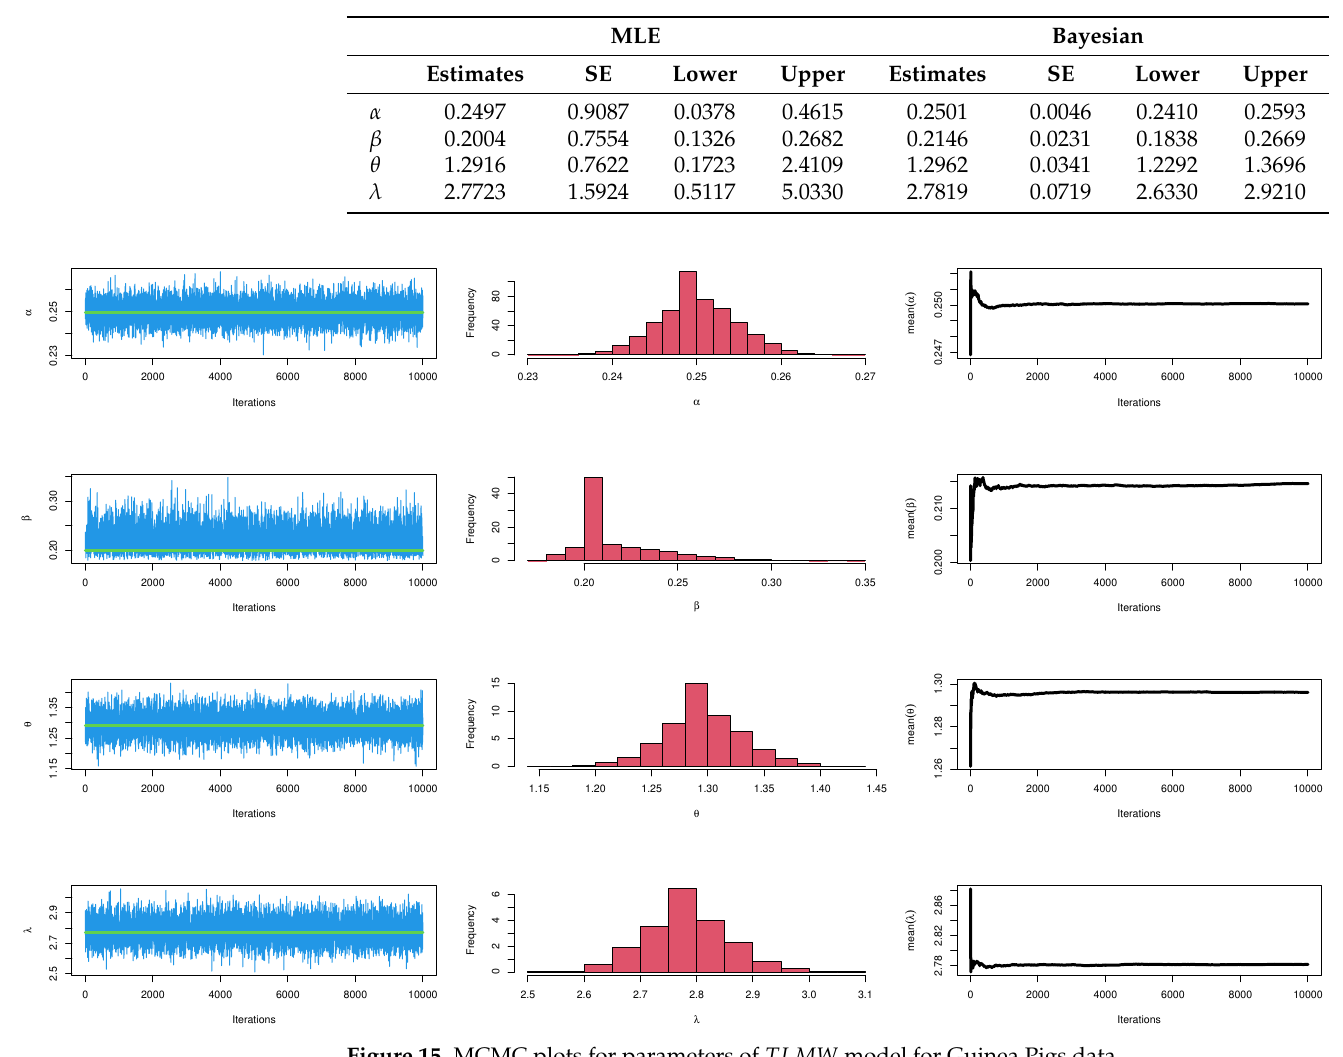
Table 12. MLE and Bayesian estimation methods of the TLMW model parameters for Guinea